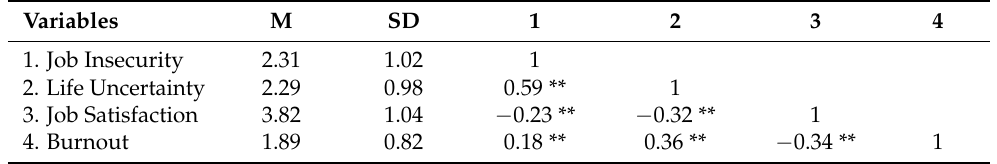
Table 2. Correlations among the variables with descriptives.